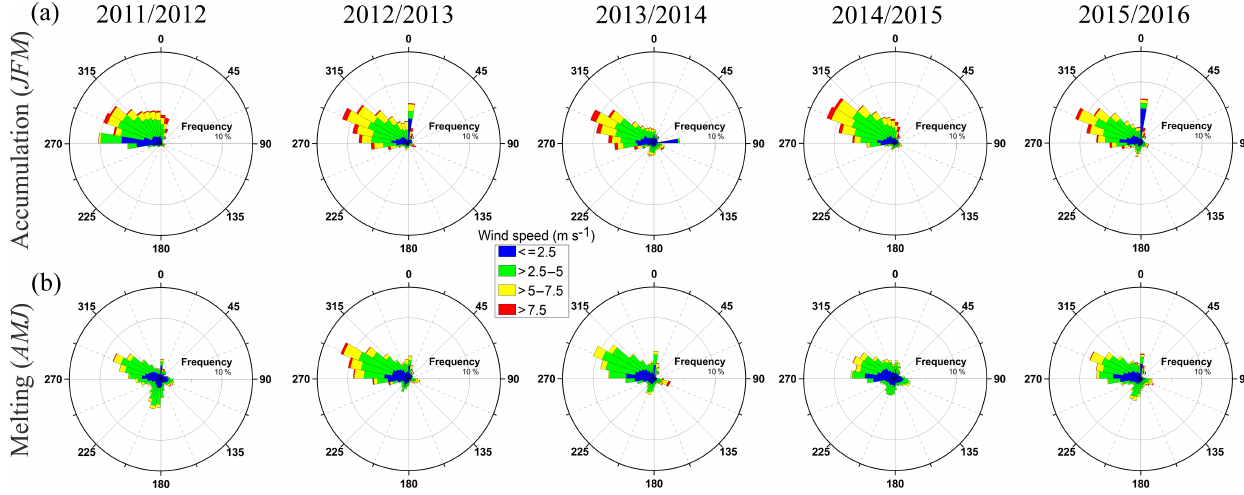
Figure 3. Wind roses showing the frequency (%) of wind speed and direction observed in the AWS for accumulation (a) and melt (b) snow seasons. Table 1. Mean and standard deviation of air temperature for the five snow seasons for the annual, accumulation and melt periods. Also shown are maximum and minimum air temperatures for each period of the snow